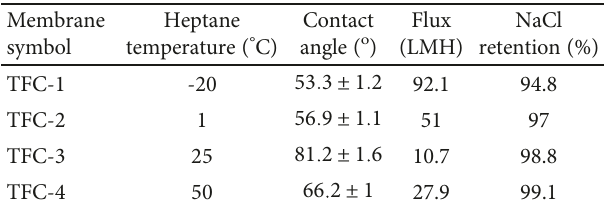
Table 2: Parameters of the membranes formed, depending on the organic solvent